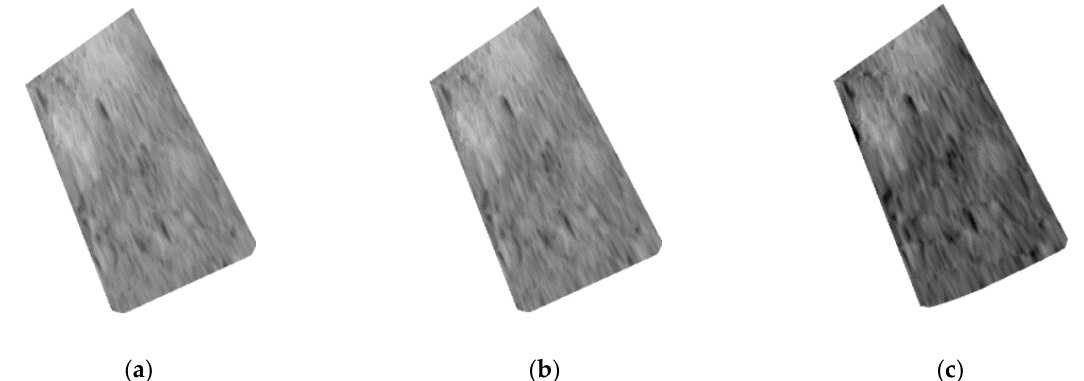
Figure 20. Reconstruction DEM results of ROI1 by three methods ( a ) SGM interpolation result, ( b ) PPS interpolation re- sult, ( c ) PSOP result from orthorectified images.